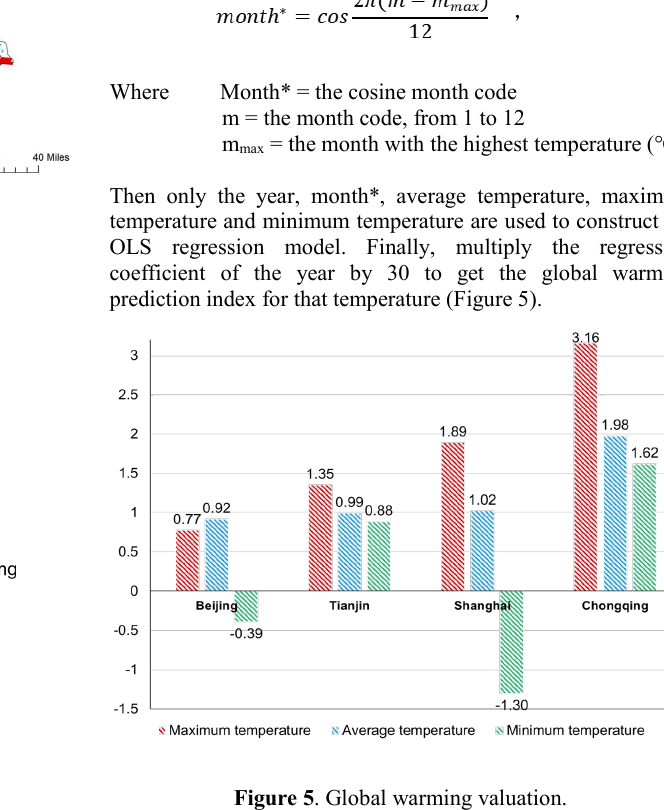
Figure 5 . Global warming